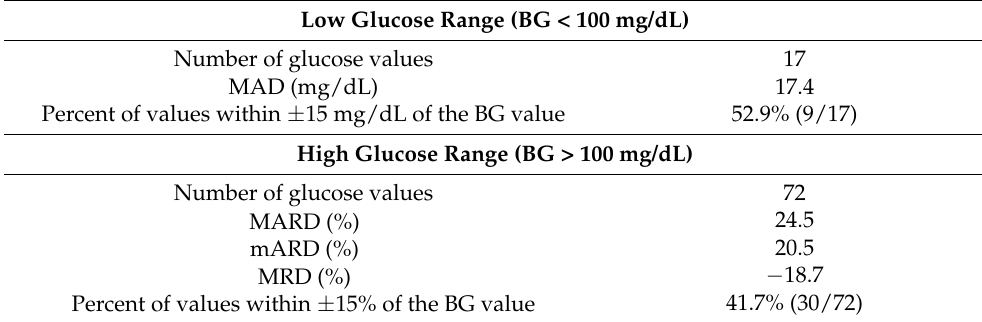
Figure 5. Bland–Altman plots represent the differences between the glucose concentrations obtained using Eversense XL versus those obtained using the PBGM (Alphatrak2) in all dogs. The PBGM glucose values plotted against absolute errors for each corresponding value are on the x-axis. The black dotted line represents a mean difference of 0 between the glucose concentrations being compared. The green line represents the mean difference between the glucose concentrations being compared, and the red lines represent the 95% limits of agreement. Table 2. Eversense’s analytical accuracy in the low (BG < 100 mg/dL) and high glucose range (BG ≥ 100